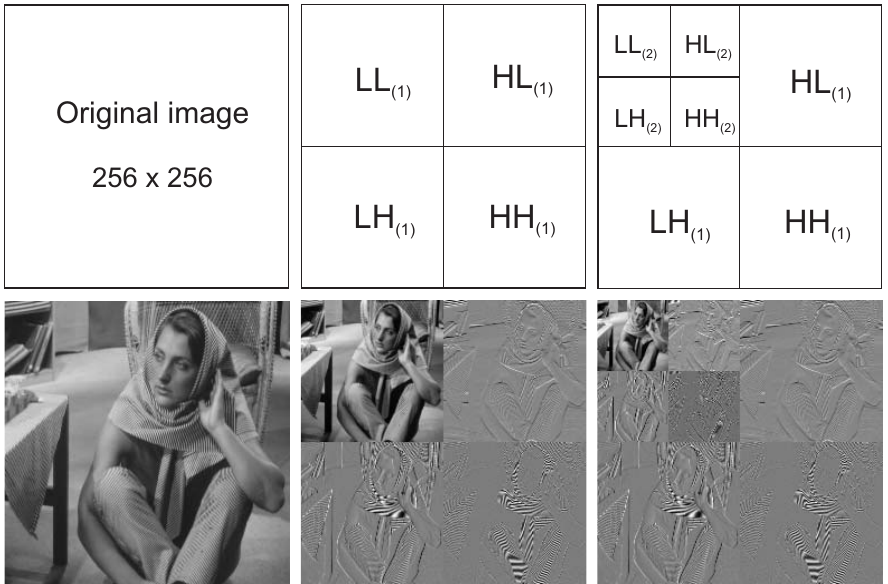
Figure 3. DWT processing generating two and three levels of